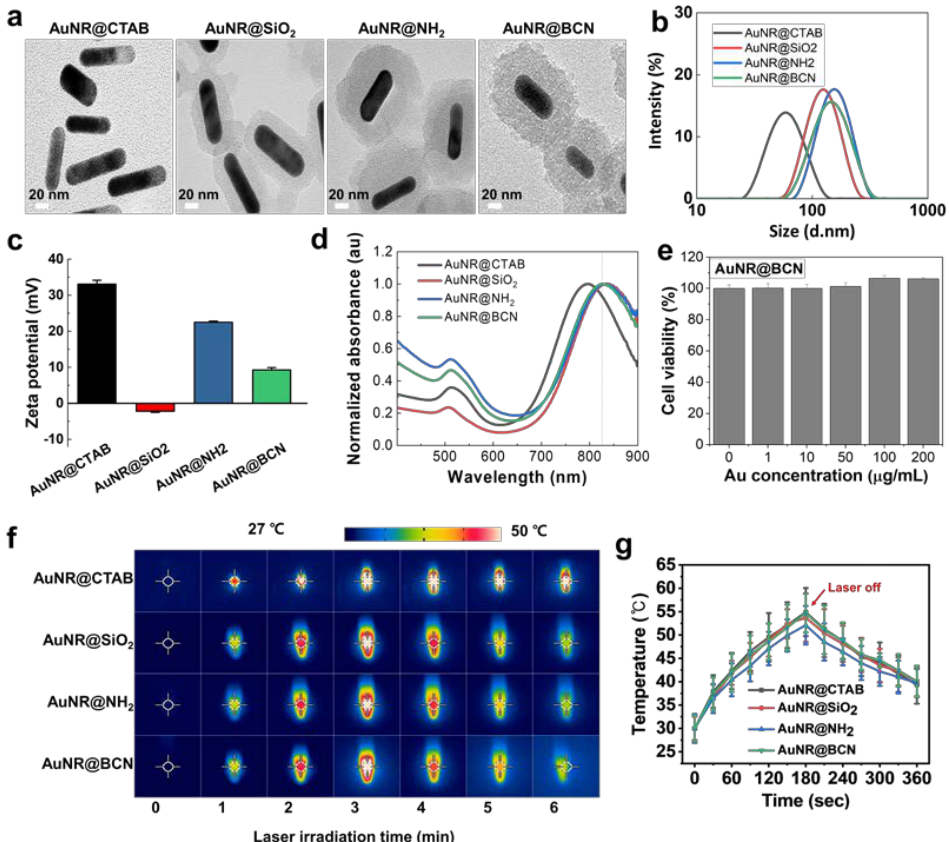
Figure 1. Preparation and characterization of AuNR@BCN. ( a ) TEM images of AuNR@CTAB,